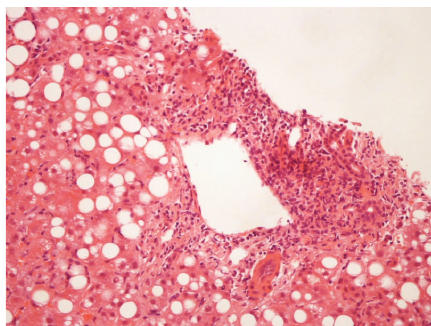
Figure2:Histologyfindings:lymphocyticinflammatoryinfiltration of portal tracts, a finding suggestive of acute